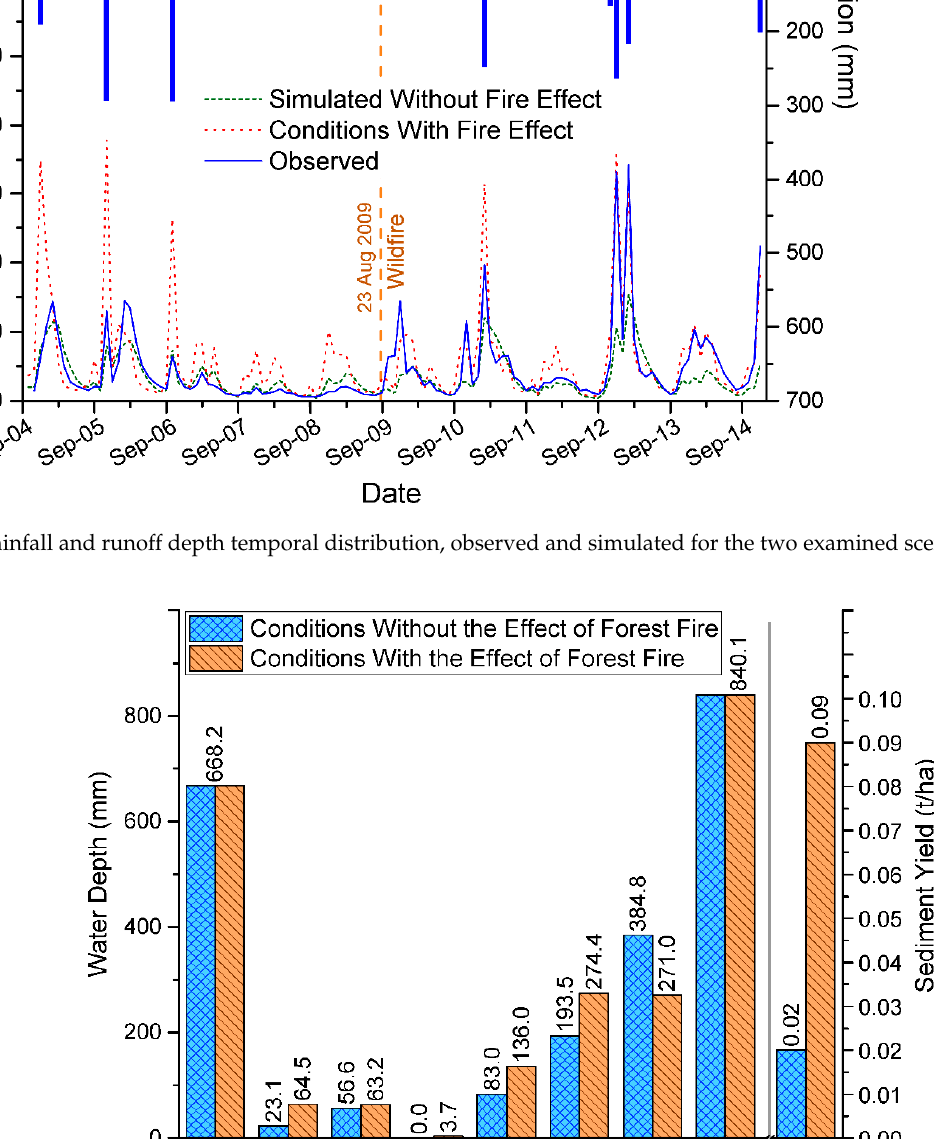
Figure 6. Graphical representation of the average annual values of the simulated water balance components for the two investigated scenarios. PREC: precipitation, REF_ET: reference evapotran- spiration, SUR_Q: surface flow, LAT_Q: lateral flow, GW_Q: groundwater flow, PERCOLATE: percolation, ACT_ET: actual evapotranspiration, SED_YIELD: sediment yield.